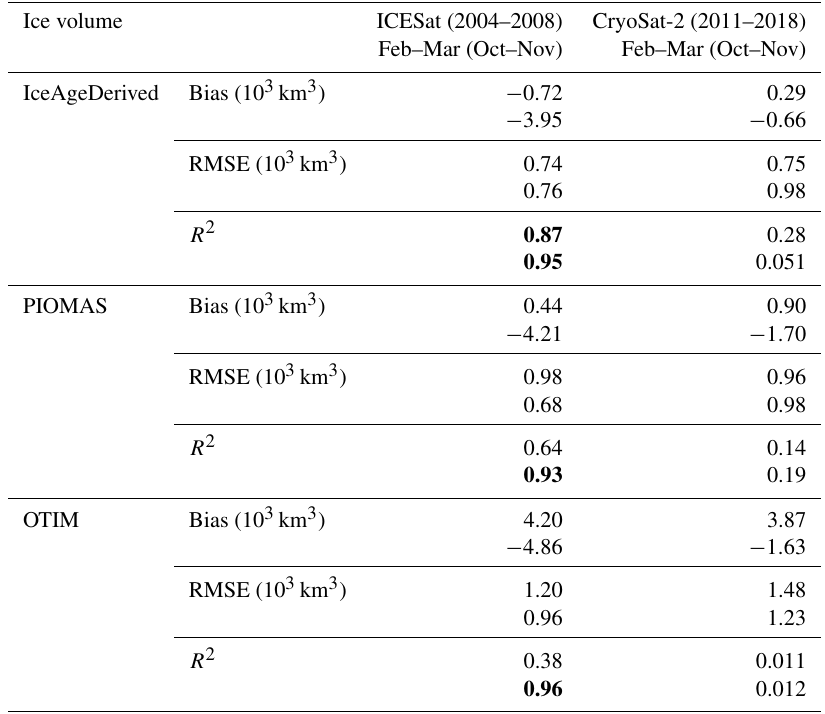
Table 2. Statistics of the comparison of Arctic ice volume from the IceAgeDerived product, PIOMAS, and OTIM to ICESat (2004–2008) and CryoSat-2 (2011–2018) in February–March (top row) and October–November (bottom row) over the Arctic Ocean. Correlation squared with a higher than 95% confidence level is in